Question: Give a one-sentence summary of this figure.
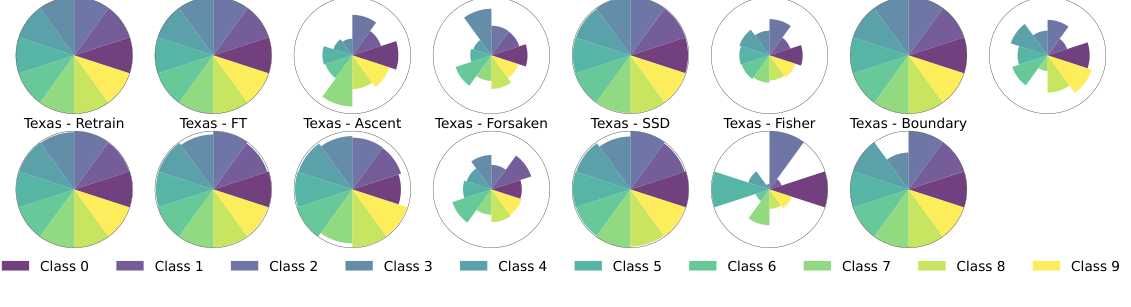
Answer: Total class unlearning results (AUC) of 10 classes